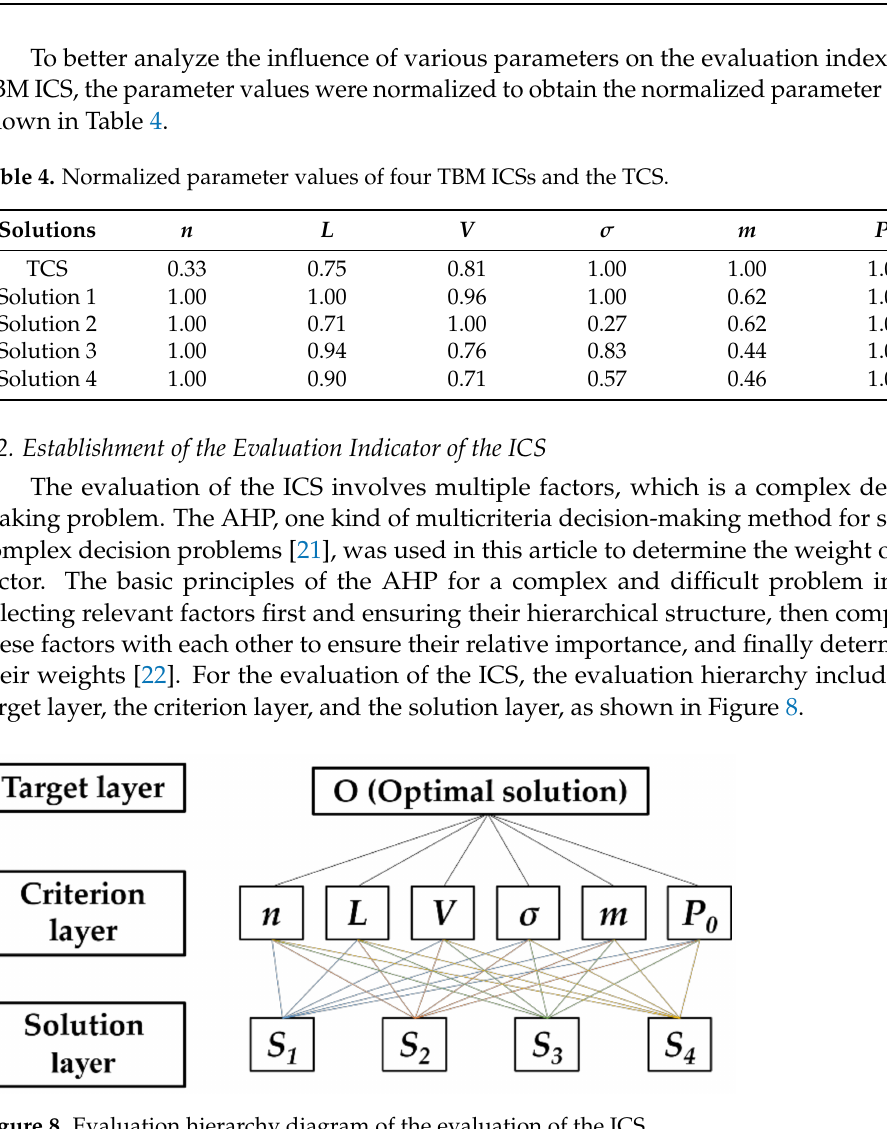
Figure 8. Evaluation hierarchy diagram of the evaluation of the